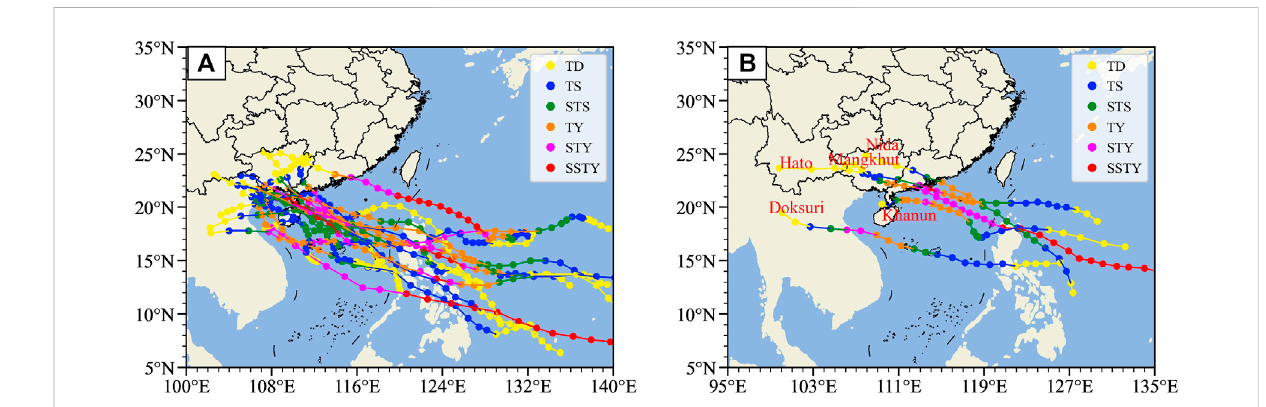
FIGURE 4 Tracks of the target TCs, including (A) 16 training samples in 2011 – 2015 and (B) fi ve independent samples in 2016 – 2018. The names of the independent samples are also shown in (B)